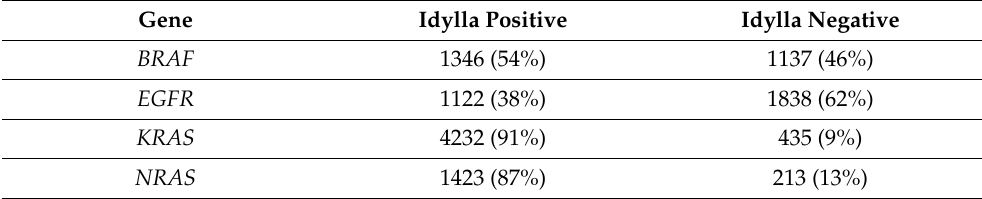
Table 1. cBioPortal for Cancer Genomics and associated gene mutations. Gene Idylla Positive Idylla Negative BRAF 1346 (54%) 1137 (46%) EGFR 1122 (38%) 1838 (62%) KRAS 4232 (91%) 435 (9%) NRAS 1423 (87%) 213